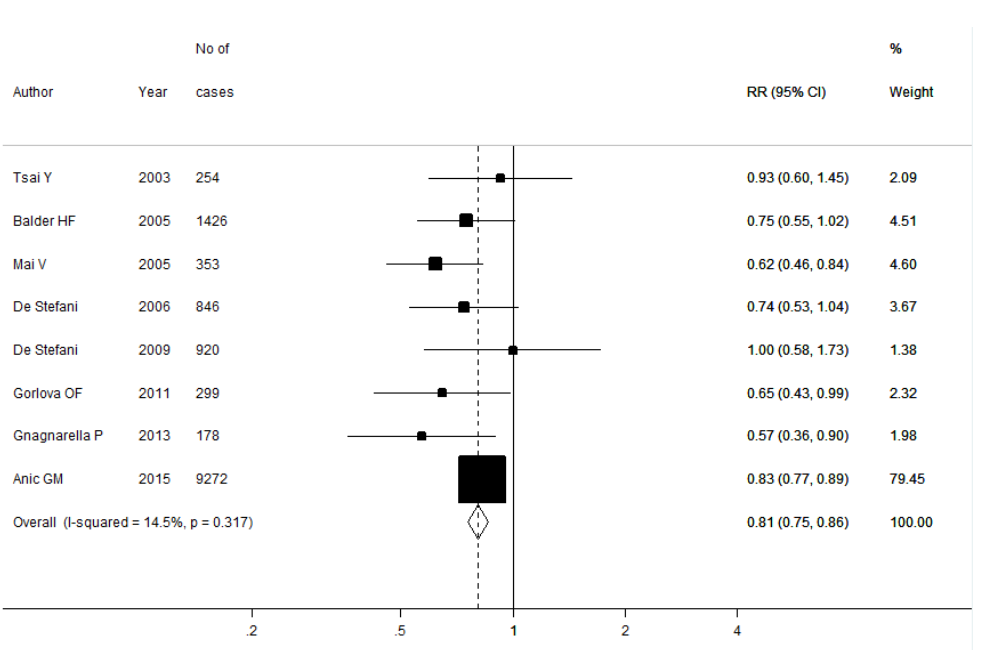
Figure 2. Forest plot of heathy dietary pattern and lung cancer risk.